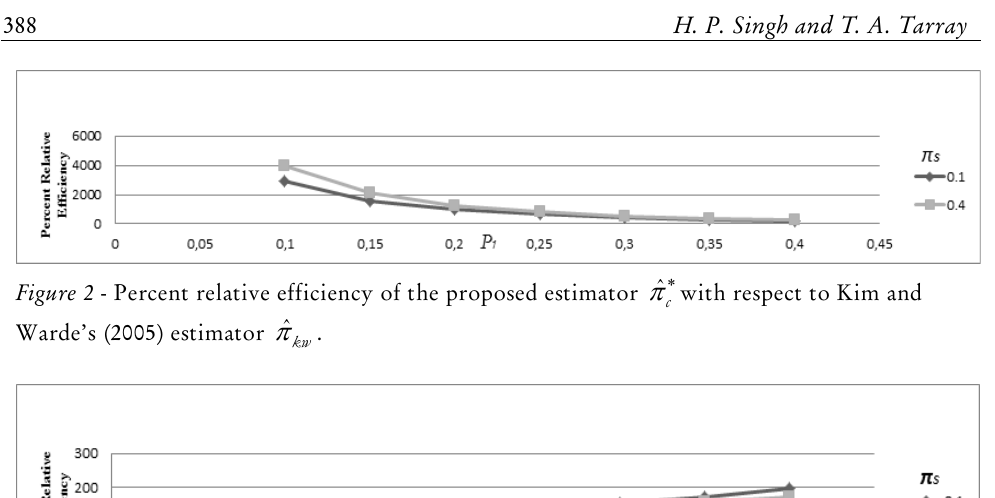
Figure. 3 - Percent relative efficiency of the proposed estimator ˆ π ∗ estimator ˆ c